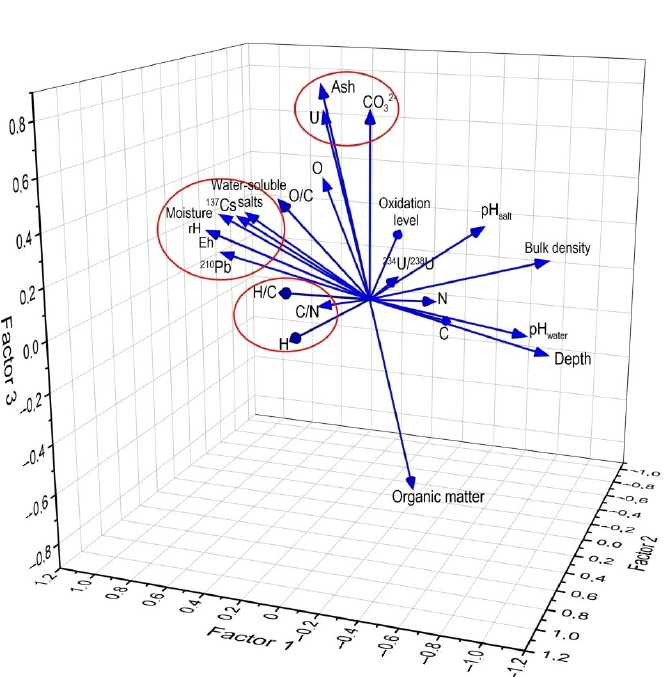
Figure 7. Plot of factor loadings for the ISNO-1 peat profile. Red circle is a group of factors.